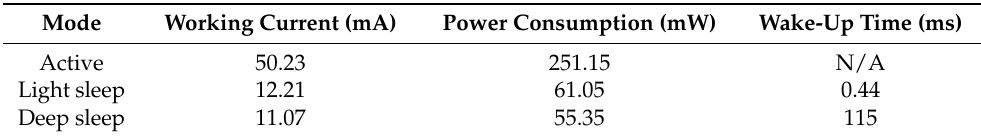
Table 4. Working current, power consumption, and wake-up time of the ESP32 module in different power